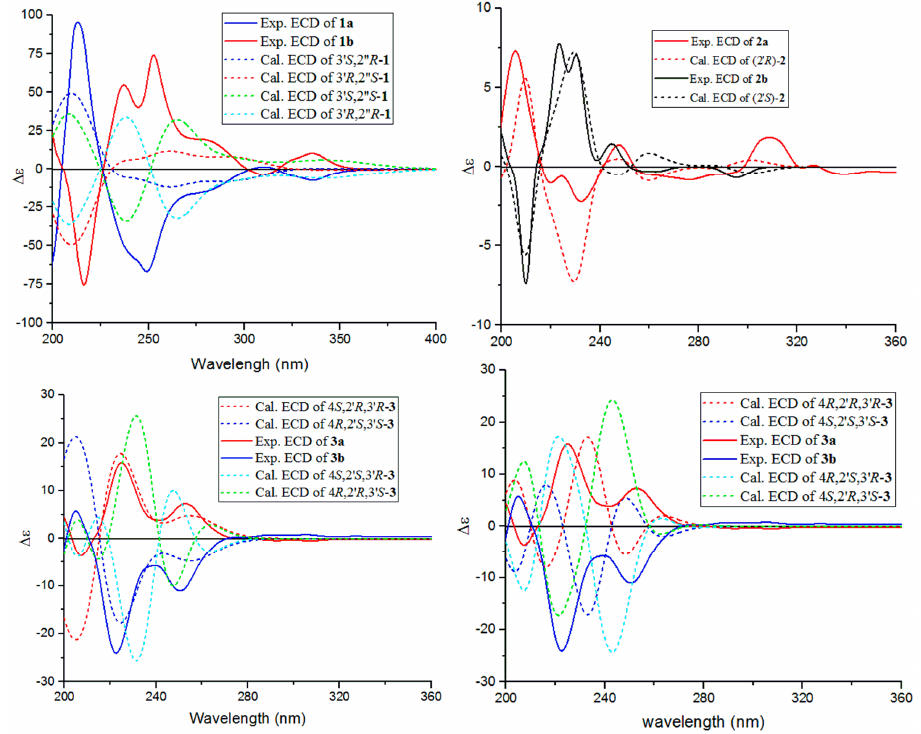
Figure 3. Experimental and calculated electronic circular dichroism (ECD) spectra of compounds 1a / 1b – 3a / 3b .